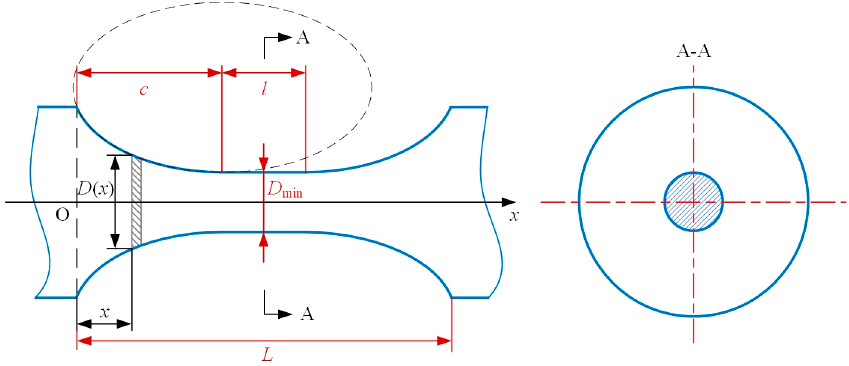
Figure 3. The diagram of the notch profile of spherical flexure hinges.